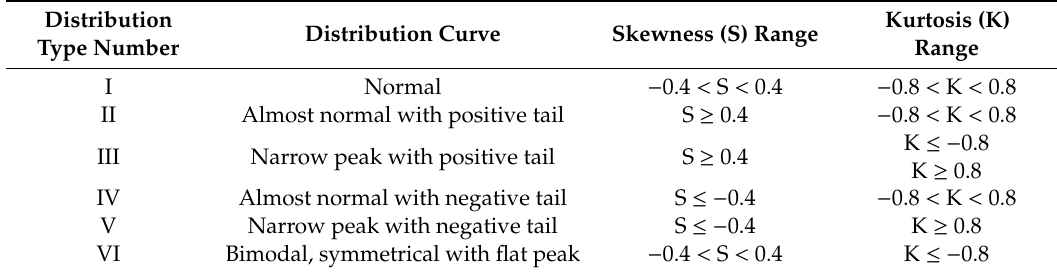
Table 2. Distribution curve selections